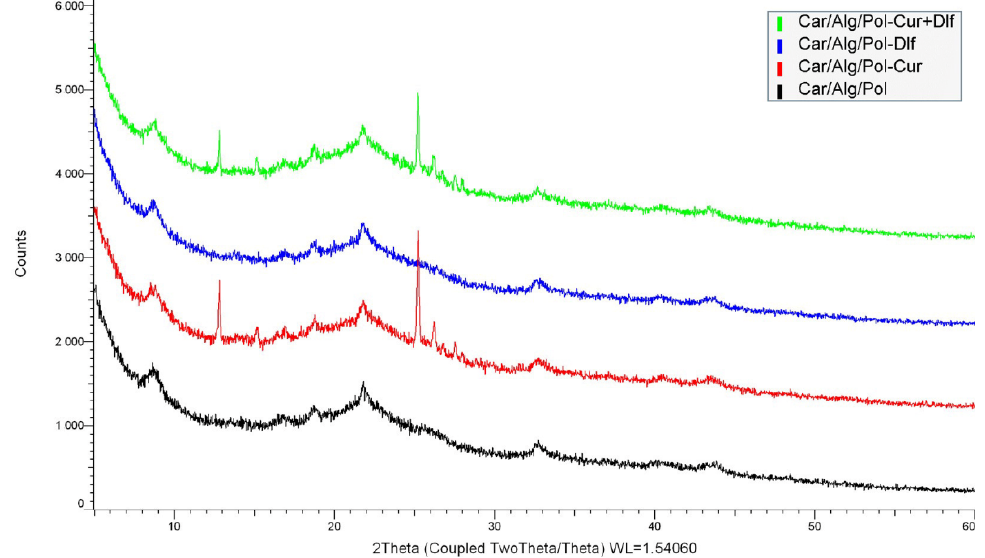
Figure 3. XRD patterns of the prepared films.